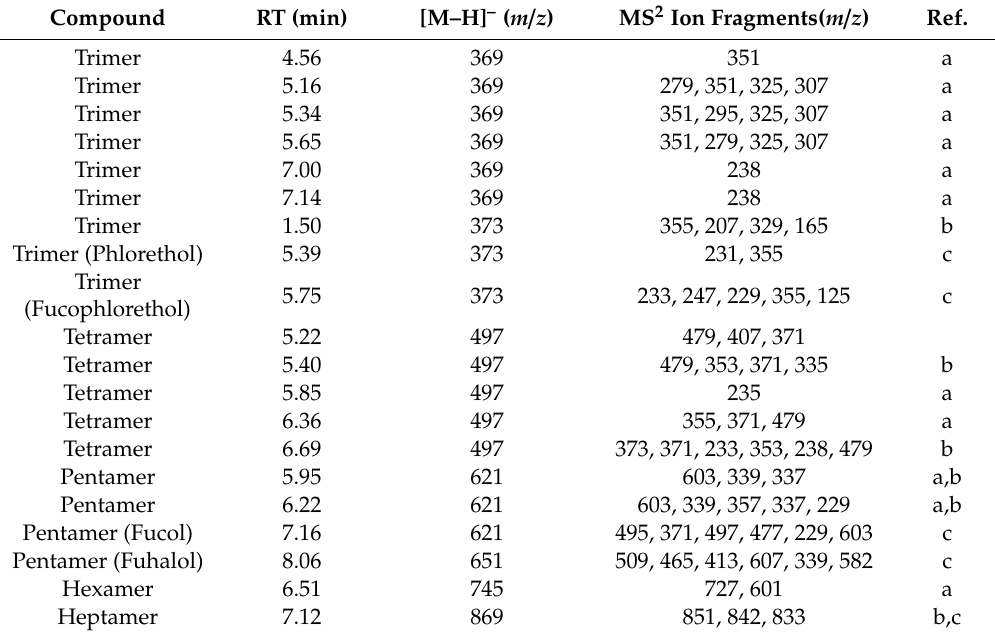
Table 2. Mass spectral characteristics of the tentatively identified phlorotannins in Himanthalia elongata ( HE